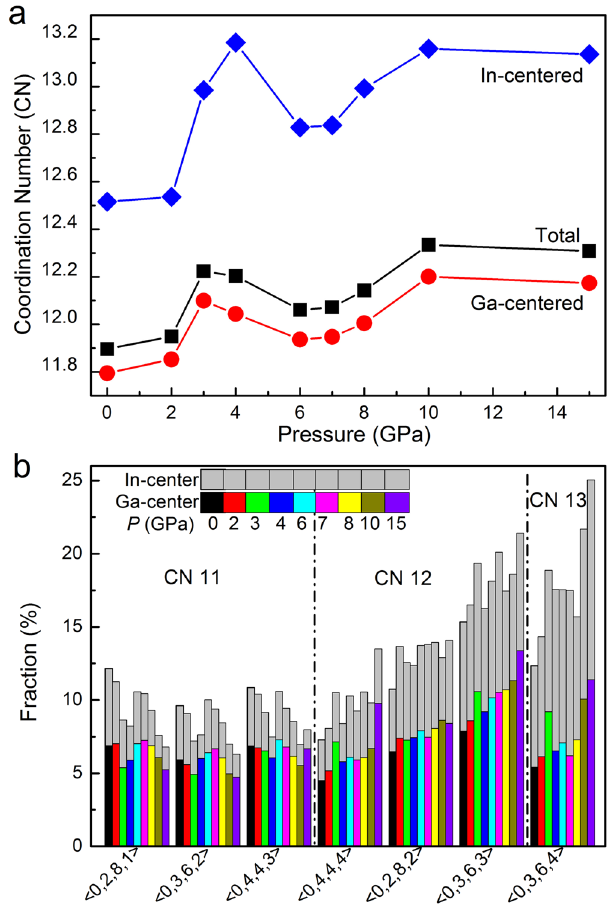
Figure 7. The structural features obtained from Voronoi tessellation ( a ) The calculated nearest-neighboring total and partial coordination numbers (CNs) with pressure in Ga 86 In 14 alloy. ( b ) The distribution of the most abundant Voronoi polyhedra around Ga and In atoms in Ga 86 In 14 alloy during